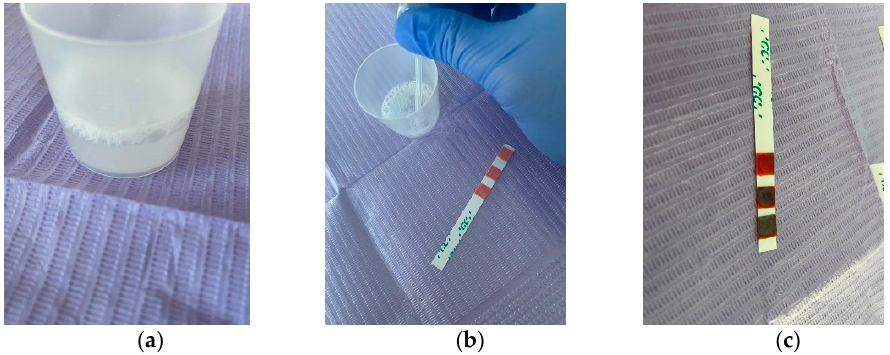
Figure 2. ( a ) Saliva collected in the dispensing cup; ( b ) Use of a pipette to apply saliva to the test strip; ( c ) Buffer test value = 8, low salivary buffer